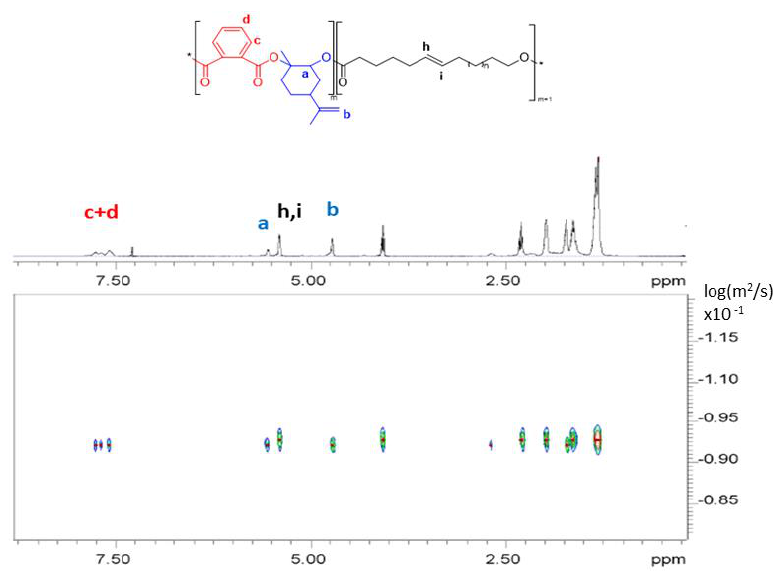
Figure 2. 2 DDOSYNMR(600MHz,CDCl 3 ,RT)ofpoly(limonene-phthalate)- block Figure 2. 2 D DOSY NMR (600 MHz, CDCl 3 , RT) of poly(limonene-phthalate)- block -poly(hexadecen- lactone).